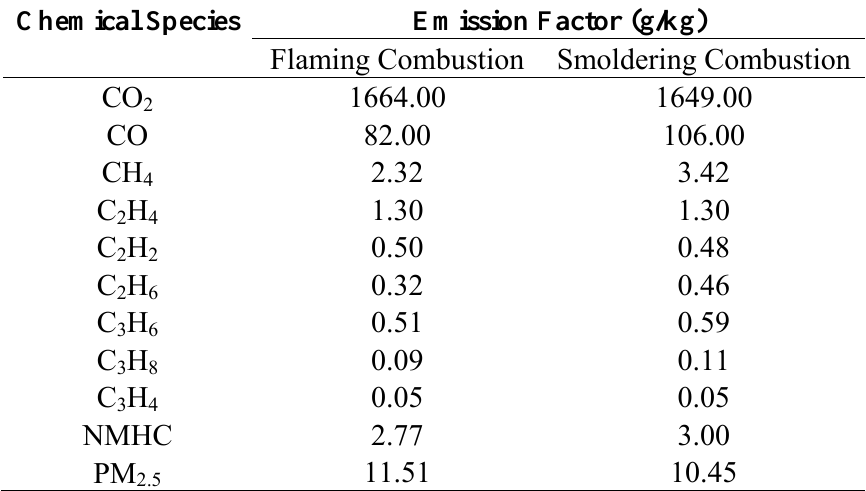
Table 3. Average emission factors from 26 southeastern prescribed